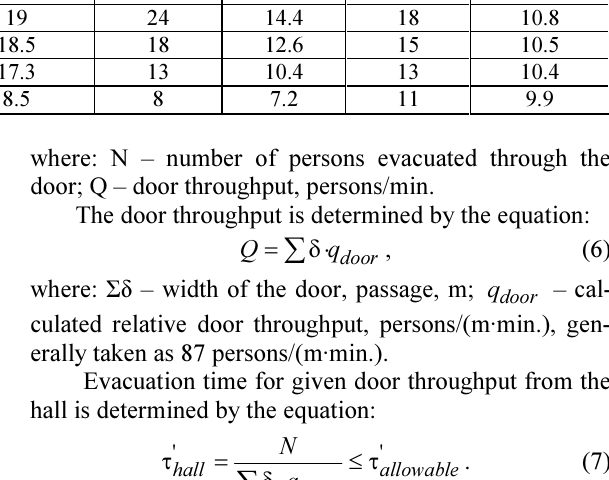
Horizontal distance Door opening Stairs down Stairs up m/min.